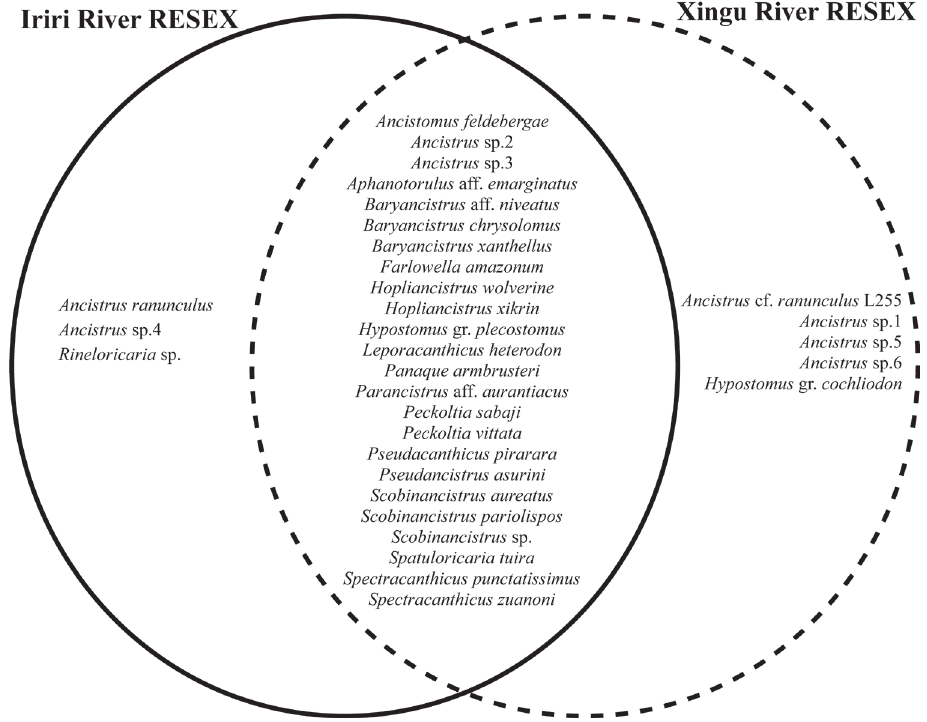
FIGURE 2 | Venn diagram showing the compositions of the Loricariidae species found in both extractive